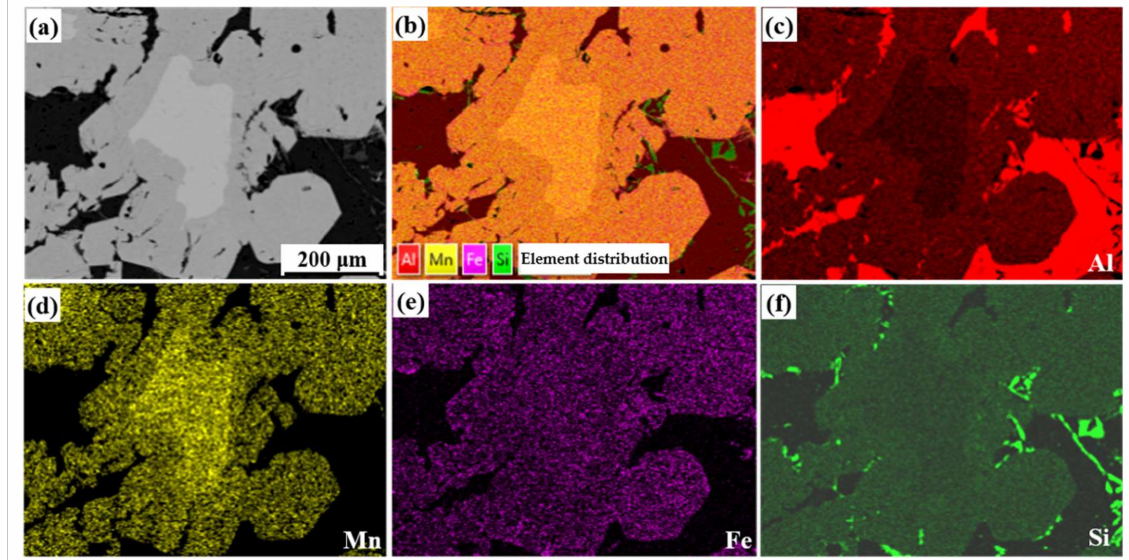
Figure 5. Elements mapping of typical Fe-rich phase in slag. ( a ) SEM image; ( b ) Comprehensive distribution of elements; ( c ) Al; ( d ) Mn; ( e ) Fe; ( f )Si.